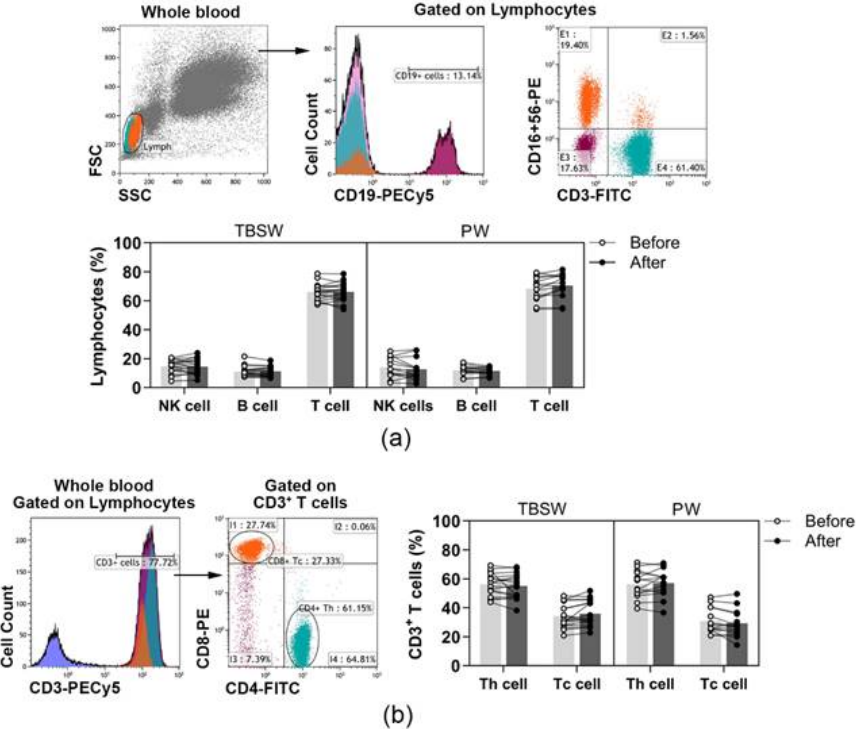
Figure 1. The distribution of peripheral lymphocyte subsets in young women before and after the exercise course. The whole blood of 32 healthy volunteers was stained with labelled monoclonal antibodies, as described previously. According to the exercise courses, the trainees were divided into total-body-shaping workout (TBSW, n = 18) and Pilates workout (PW, n = 14) subgroups. ( a ) Representative dot plots and a histogram show the gating strategy of CD3 − CD16 + CD56 + NK, CD19 + B, and CD3 + CD16 − CD56 − T cell populations. The bar chart shows the percentages of NK, B, and T cells. ( b ) The representative histogram shows the gating of CD3 + cells, and the dot plots demonstrate the distribution of CD4 + Th and CD8 + Tc cells. The bar chart indicates the frequencies of Th and Tc cells. Data analysis was performed with repeated measures two-way ANOVA followed by Bonferroni multiple comparisons test. Each data point represents an individual subject, while bars show the mean